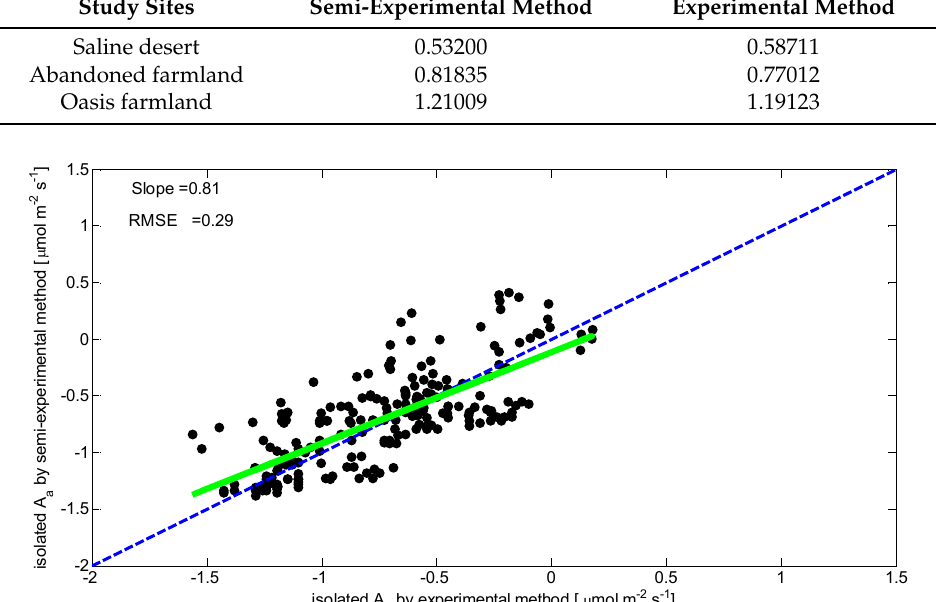
Table 2. Q 10 values for isolated R m by two methods.